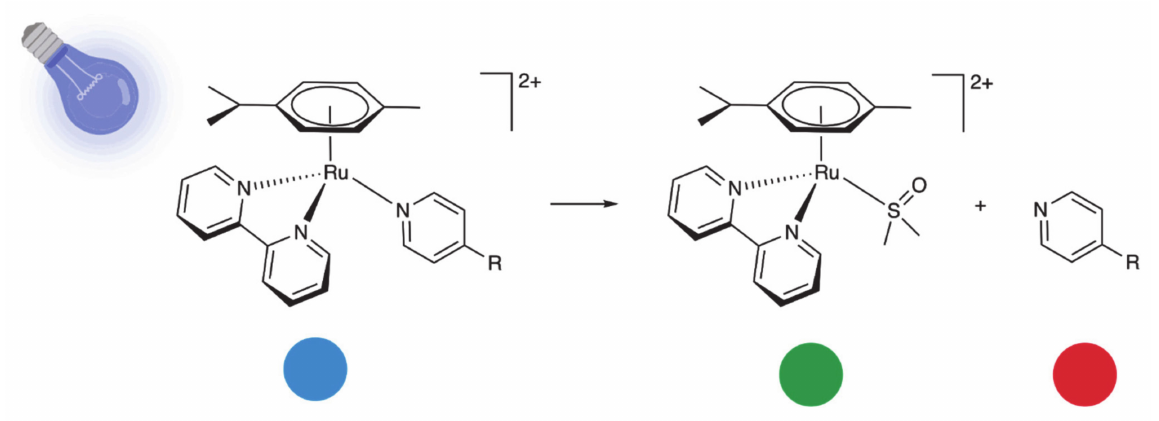
Scheme 2. Mechanism of photolysis of the